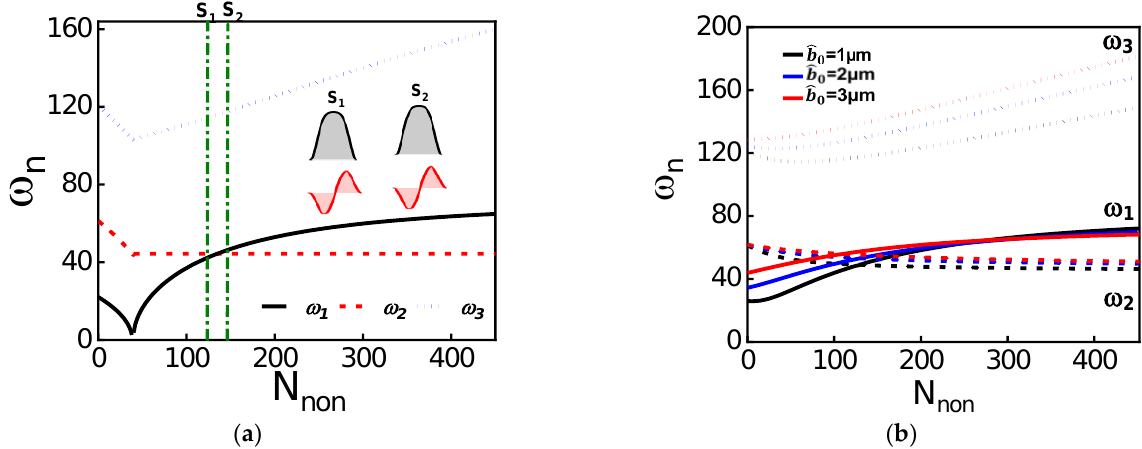
Figure 5. ( a , b ): The variation of the three lowest natural frequencies with axial load. ( a ) Case of the straight beam. ( b ) Case of an arch beam with different initial rises. The insets of ( a ) are the associated modes shapes of the first two lowest frequencies before the crossing (S 1 ) and after the crossing (S 2 ).